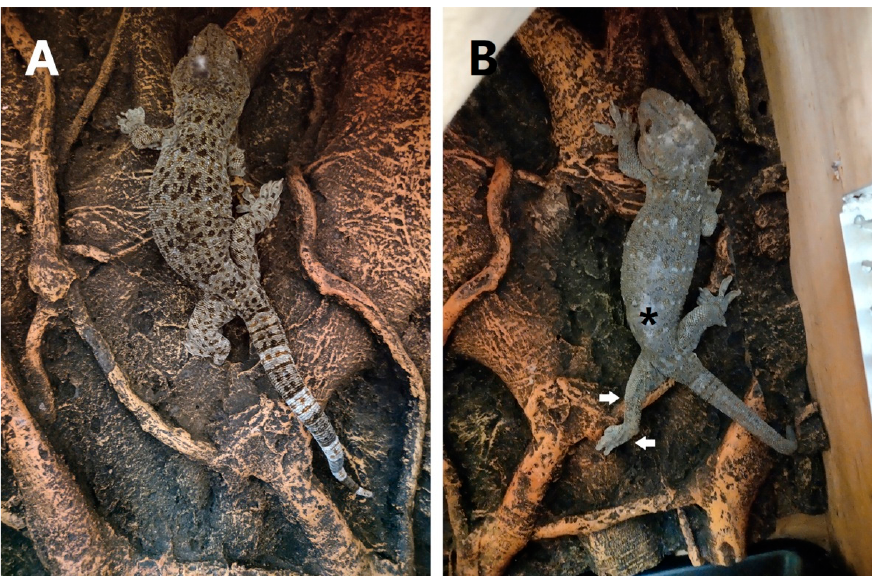
Figure 1. Examples of geckos on the vertical oak background board in the terraria before ( A ) and after ( B ) a dorsal hemisection (asterisk indicate the point of hemisection). ( A ) A normal gecko of alertly behaving in a resting position, the condition of foot position and toe attachment indicating that they actively load the adhesive system to resist gravity and respond dynamically to external perturbations. ( B ) A gecko after ≥ 6 mth post-hemisection, presenting a quite abnormal constrained locomotion since a permanently non-hyperextended state of the left hind limb caused the crus to come into line with the pes (arrowheads), while the right hind limb motioned well with a lower thoracic level since the need of grasping was the prominent part.